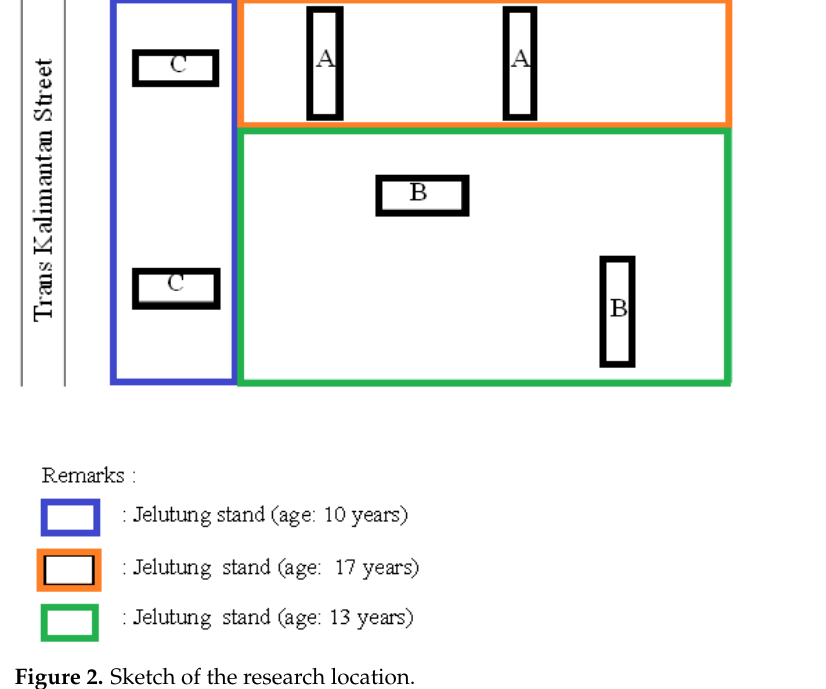
Figure 2. Sketch of the research location.